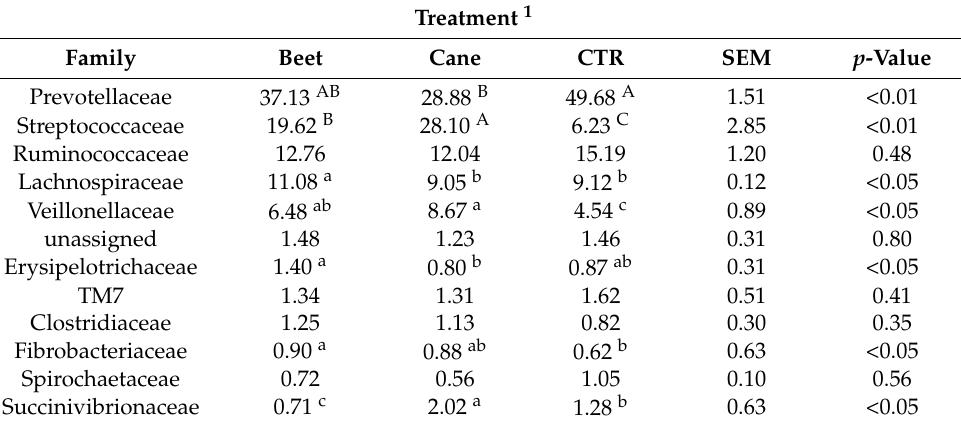
Figure 1. Alpha and beta diversity of the rumen microbial community in beet, cane, and CTR groups. ( A ) Boxplots showing the distribution of alpha diversity, according to the number of observed ASVs, in beet, cane, and CTR groups. Wilcoxon test, * p < 0.05. ( B ) Principal coordinates analysis of beta diversity, based on unweighted UniFrac distances, of all samples. A significant separation was found between CTR and other groups (PERMANOVA, p = 0.01). Same color code as in ( A ). Table 4. Rumen family-level microbial composition in beet, cane, and CTR groups at 24 h of incuba- tion. For each family, the relative abundance (% of the total) is